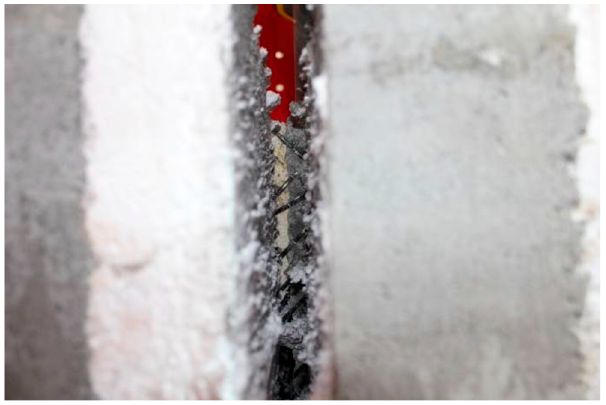
Figure 20. Typical view of combined rupture and pull-out failure mode.